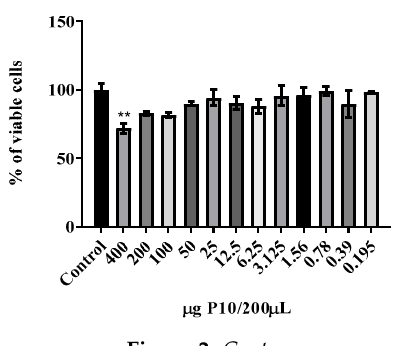
incubation, almost all concentrations of the P10 nanoparticles showed some degree of toxicity but none caused more than 50% none caused more than 50% cytotoxicity.